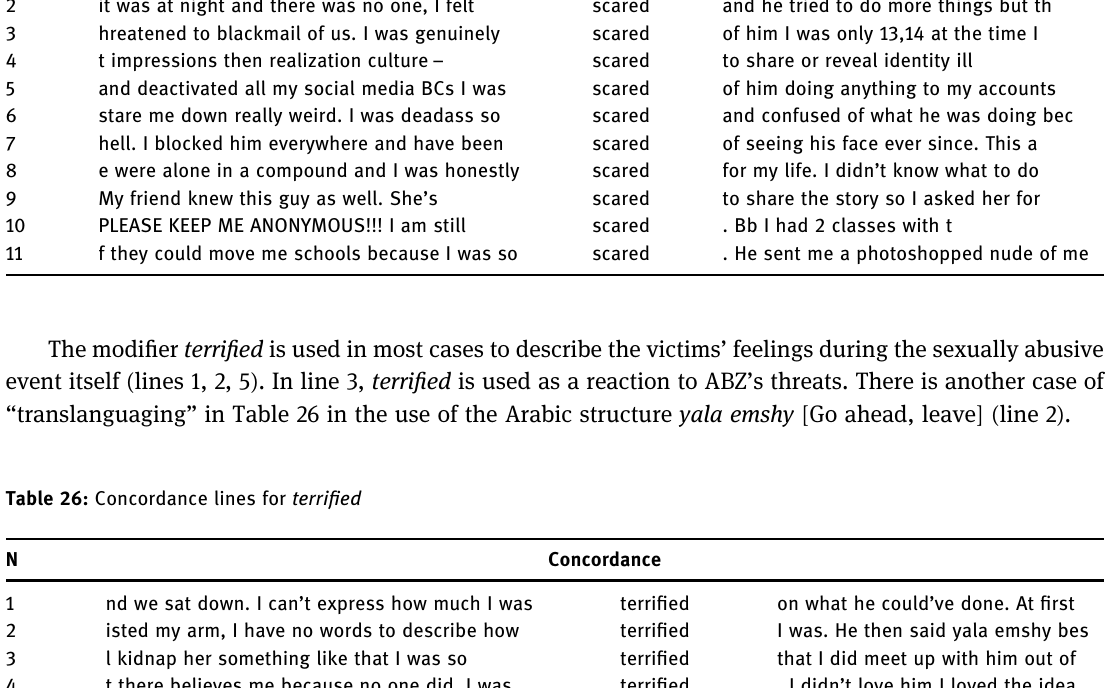
Table 25: Concordance lines for scared N